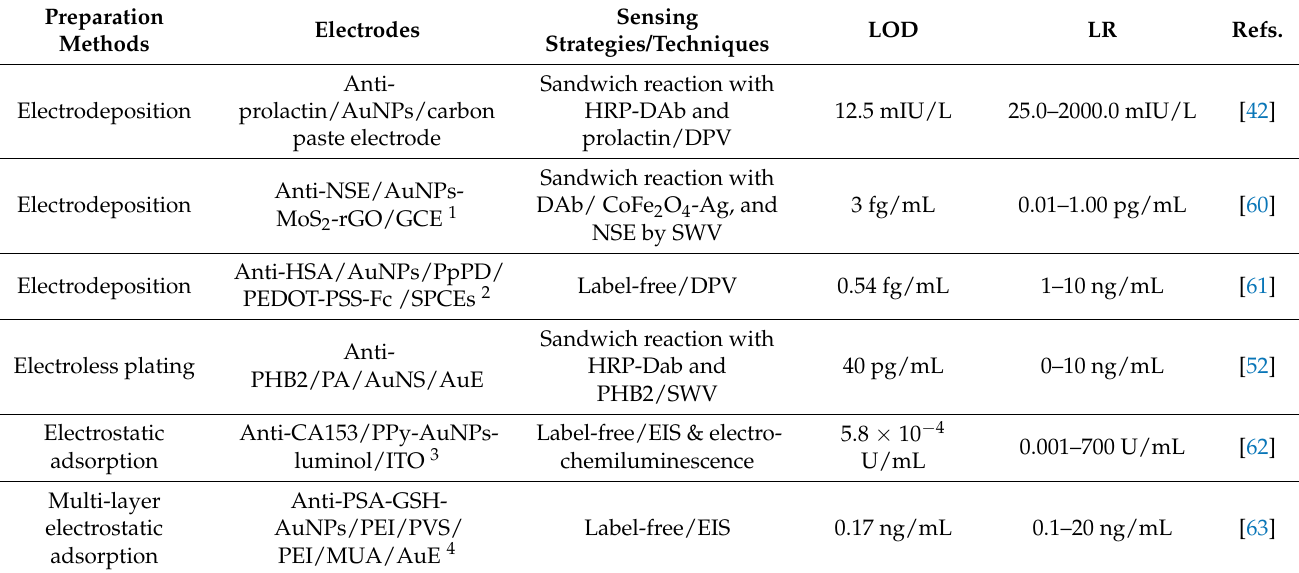
Table 1. Deposition methods of AuNPs or AuNSs for immunosensor